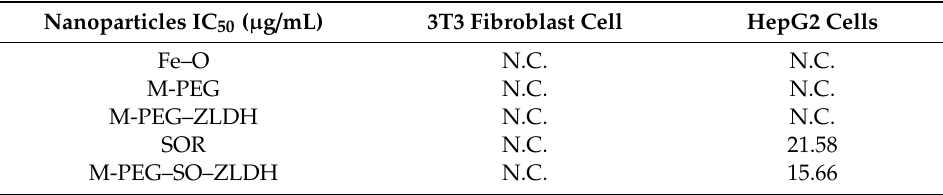
Table 3. The half-maximal inhibitory concentration (IC 50 ) value for Fe–O, M-PEG, M-PEG–ZLDH (nanocarriers), pristine sorafenib, and M-PEG–SO–ZLDH samples tested on 3T3 and HepG2 cell